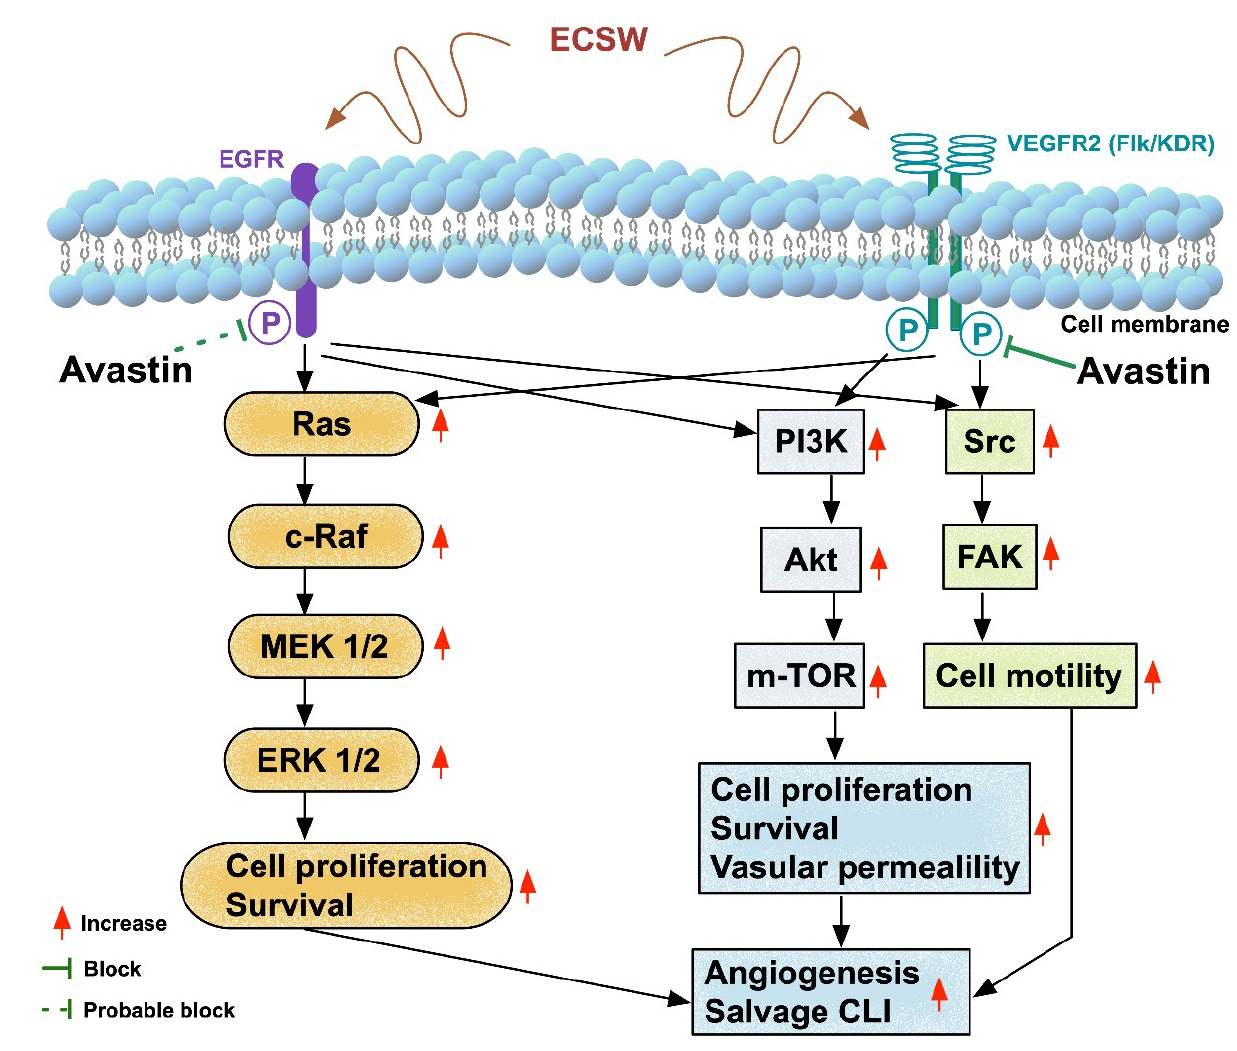
Figure 10. Schematical illustration of the underlying mechanism of ECSW therapy on salvaging CLI in mice. ECSW = extracorporeal shock wave; EGFR = epidermic growth factor receptor; VEGFR = vascular endothelial growth factor receptor; CLI = critical limb ischemia.